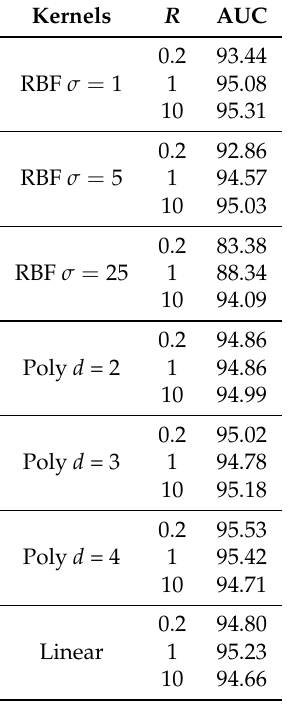
Table 5. Area of ROC (AUC %) on the k -fold using support vector machine (SVM) models with kernels and parameters (Class A features as